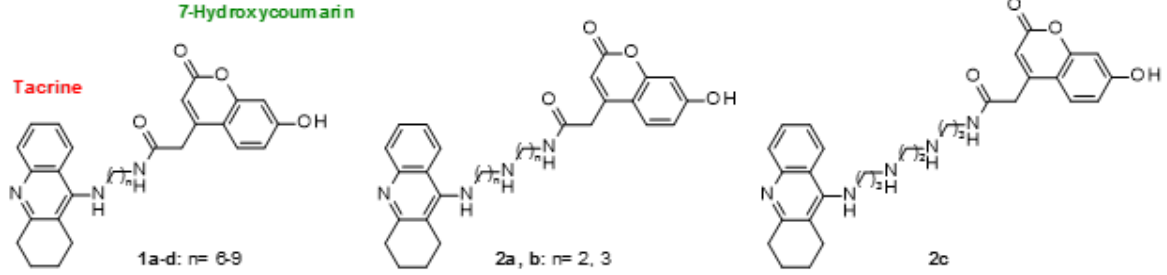
Figure 7. Structure of tacrine-coumarin hybrid molecules (derivatives 1a – 1d and 2a – 2c ) [1].